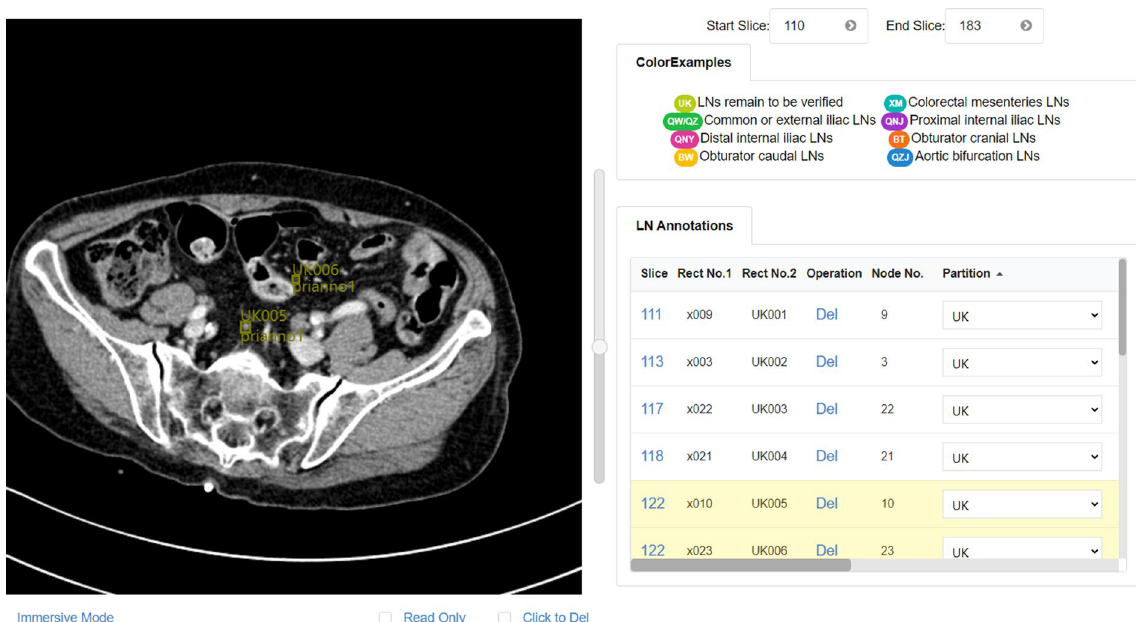
Figure 6. The annotating/reviewing page of the working interface (zoom mode and